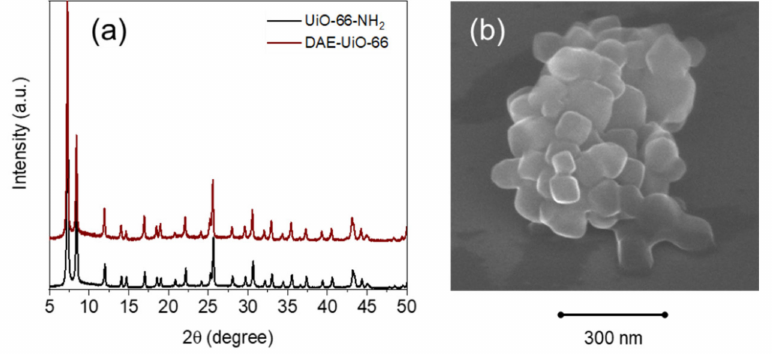
Figure 3. ( a ) XRD profiles of the UiO-66-NH 2 (black) and DAE-UiO-66 (brown) samples. Inten- sities are normalized and shifted along the y -axis for better representation. ( b ) SEM image of DAR-UiO-66